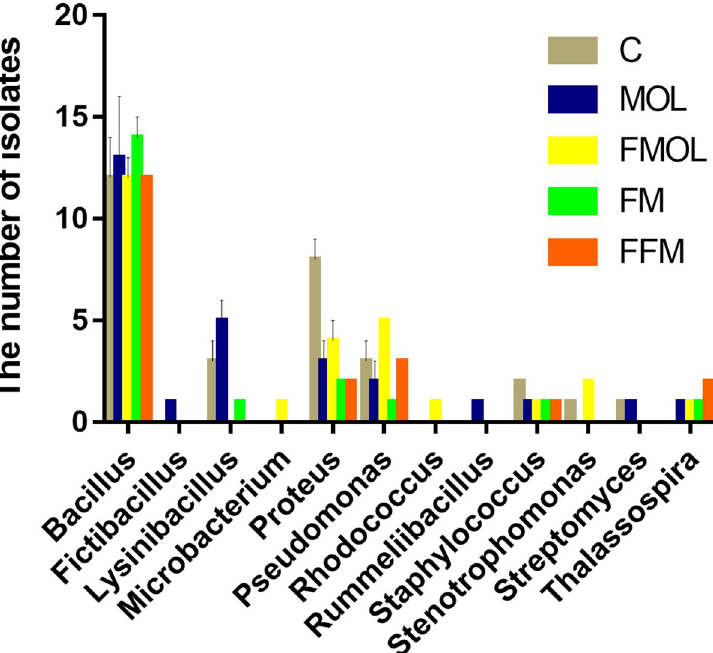
Fig 2. The intestinal bacteria communities at genus level. The color-coded bar plot showed the numbers of isolates of 12 genera in 5 groups.